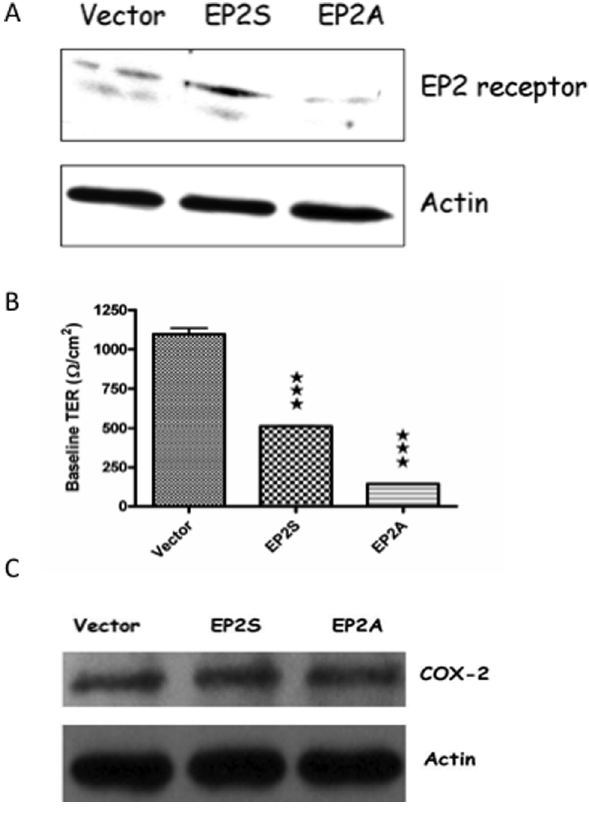
Figure 1. Differential EP2 receptor expression alters TER of Caco-2 epithelial monolayer. (A) A representative immunoblot showing differential EP2 receptor (52 KDa) expression in stable Caco-2 transfectants expressing either high (EP2S) or low (EP2A) EP2 receptors. Vector alone-transfected cells were used as a control. Actin was used as an internal control. (B) The Caco-2 cells (from the above experiments) were seeded on 12-transwell plates and after confluence was reached the TER measured. Basal resistance was measured using a Millicell ERS apparatus and expressed as ohms/cm 2 . TER of each group (n=6) was statistically compared with that of the vector control. www p , 0.001. (C) A representative immunoblot showing no change in the expression levels of COX-2 in EP2S/A cells and the vector